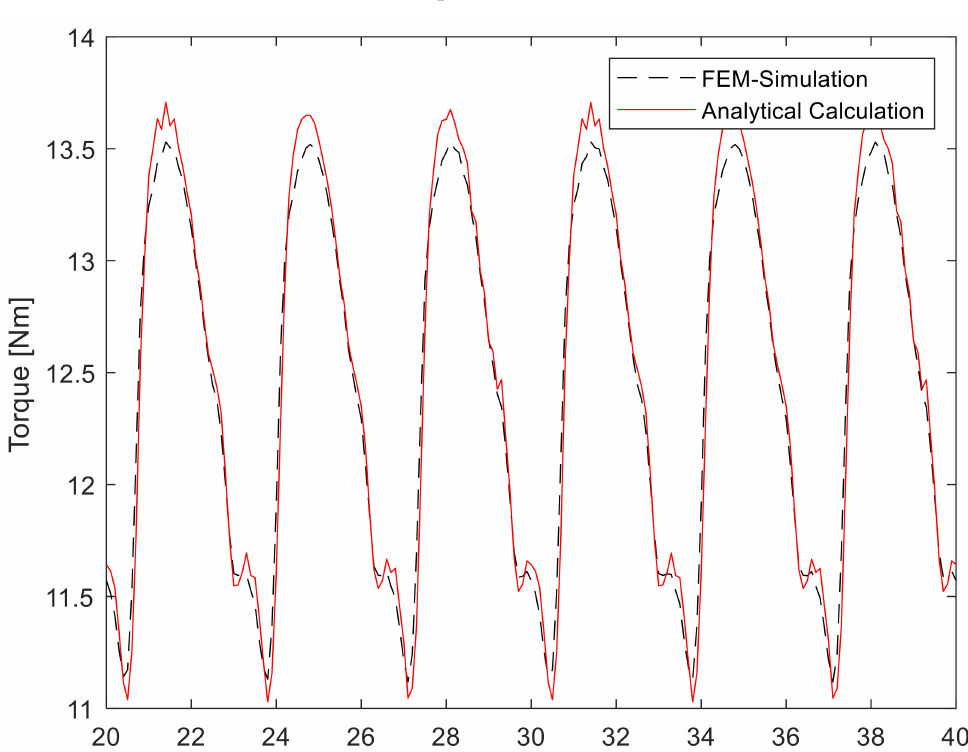
Figure 3. Torque curve of machine